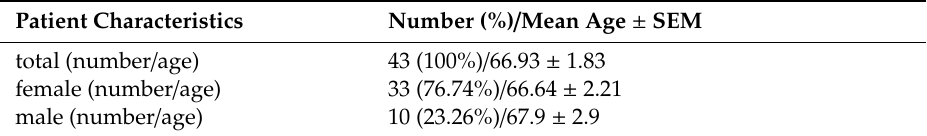
Table 2. Characteristics of patients under